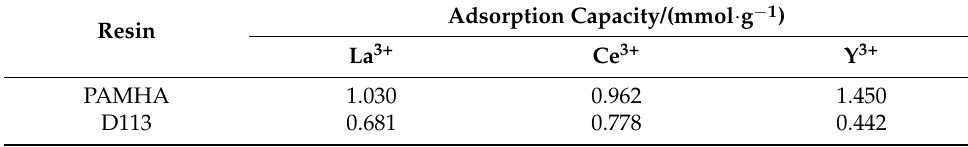
Table 5. Adsorption capacity of PAMHA on rare earth ions.